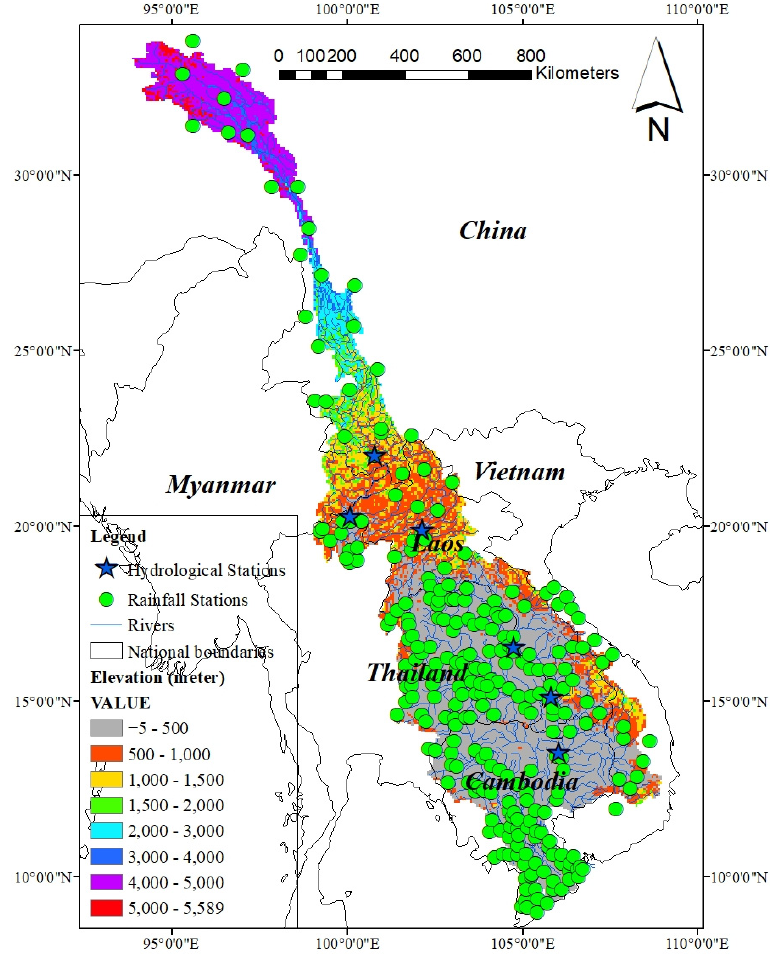
Figure 1. Location of the Lancang–Mekong − River in Asia and its topographical map. Distribution of are Yunjinghong, Chiang Saen, Luang Prabang, Mukdahan, Pakse, and Stung rainfall gauge stations and six hydrological stations: from north to south, the hydrological stations are Yunjinghong, Chiang Saen, Luang Prabang, Mukdahan, Pakse, and Stung Treng).